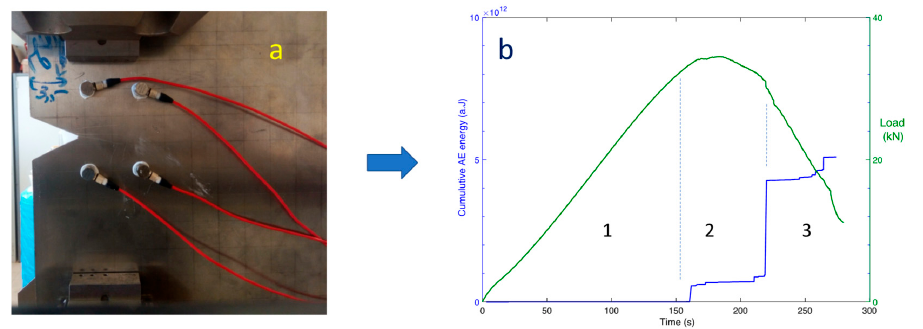
Figure 8. ( a ) Notched aluminum plate mounted on the testing machine; ( b ) evolution of the applied load as well the AE activity during the quasi-static tensile test, where AE is almost absent in (1), then a sudden and low increase in the AE activity is recorded in (2), and finally an important increase in the AE activity is recorded in (3).